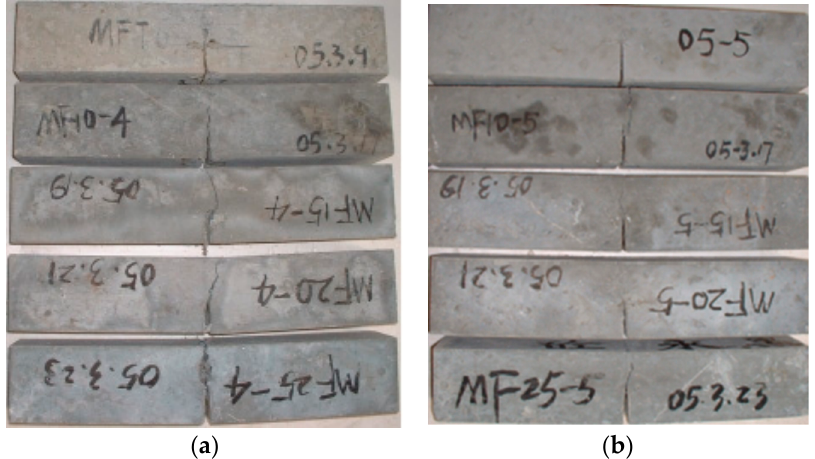
Figure 7. Comparison of crack face failure mode between SFHSC beams reinforced with different ρ f at a 0 /h = 0.4 ( a ) and a 0 /h = 0.5 ( b ).